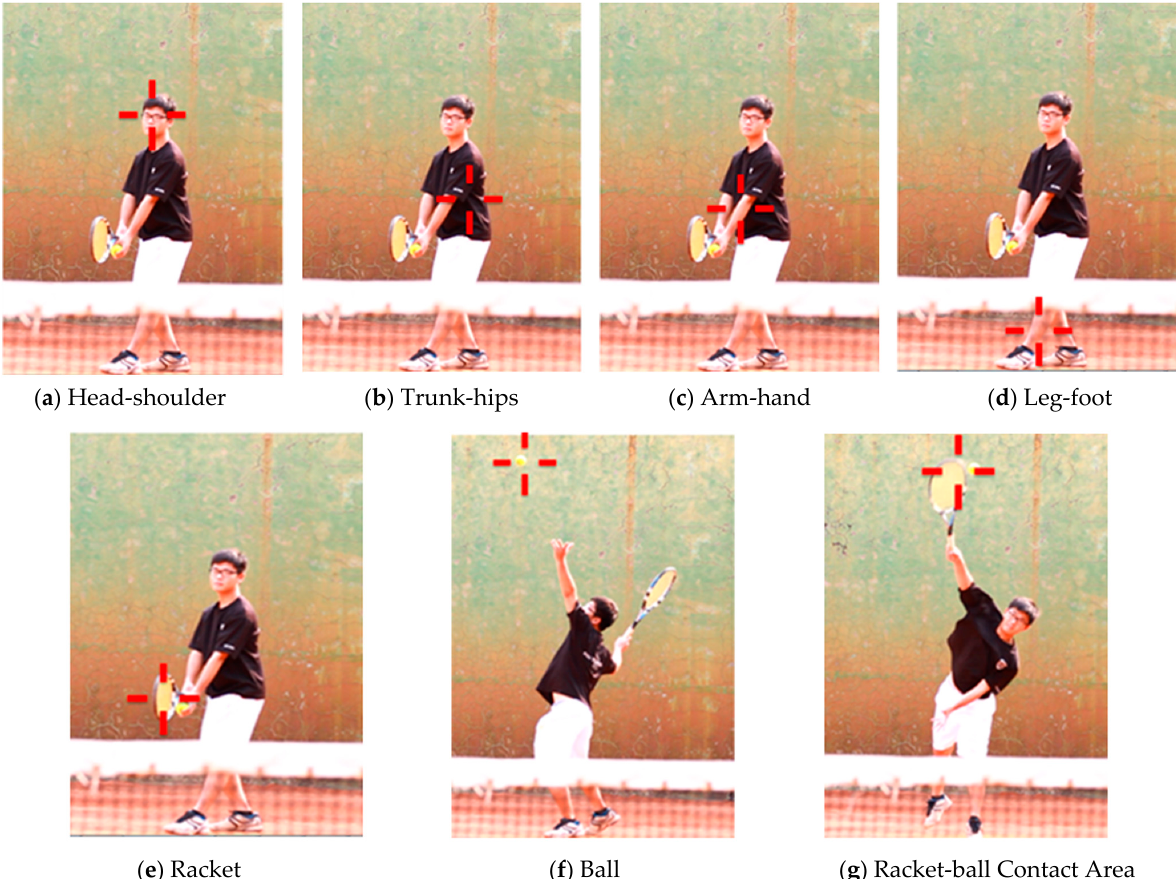
Figure 2. Body division on seven ROIs.